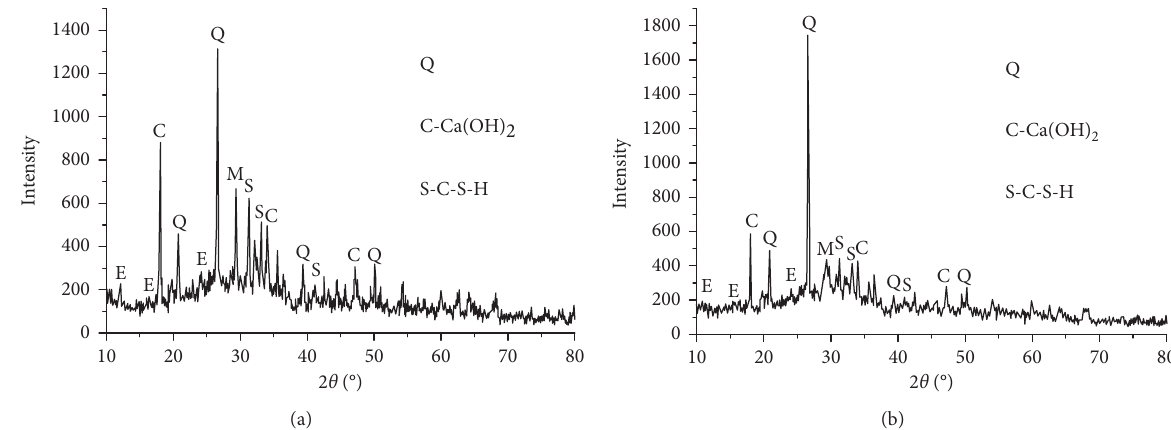
Figure 6: XRD patterns of hydration products at different ages with 50% fly ash without activator. (a) 3-day hydration; (b) 28-day hydration.